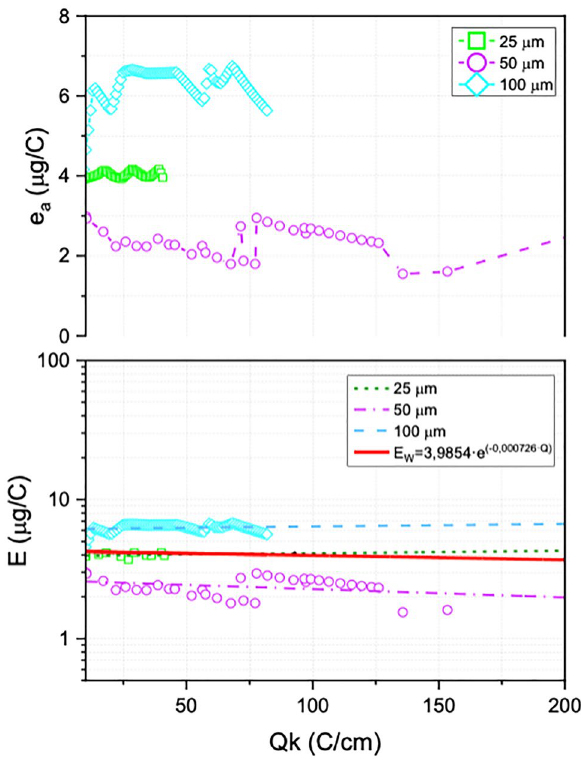
Figure 4. Average erosion rate (e a ) and global erosion rate (E) depends on charge transferred per unit length Q considering different tungsten wire